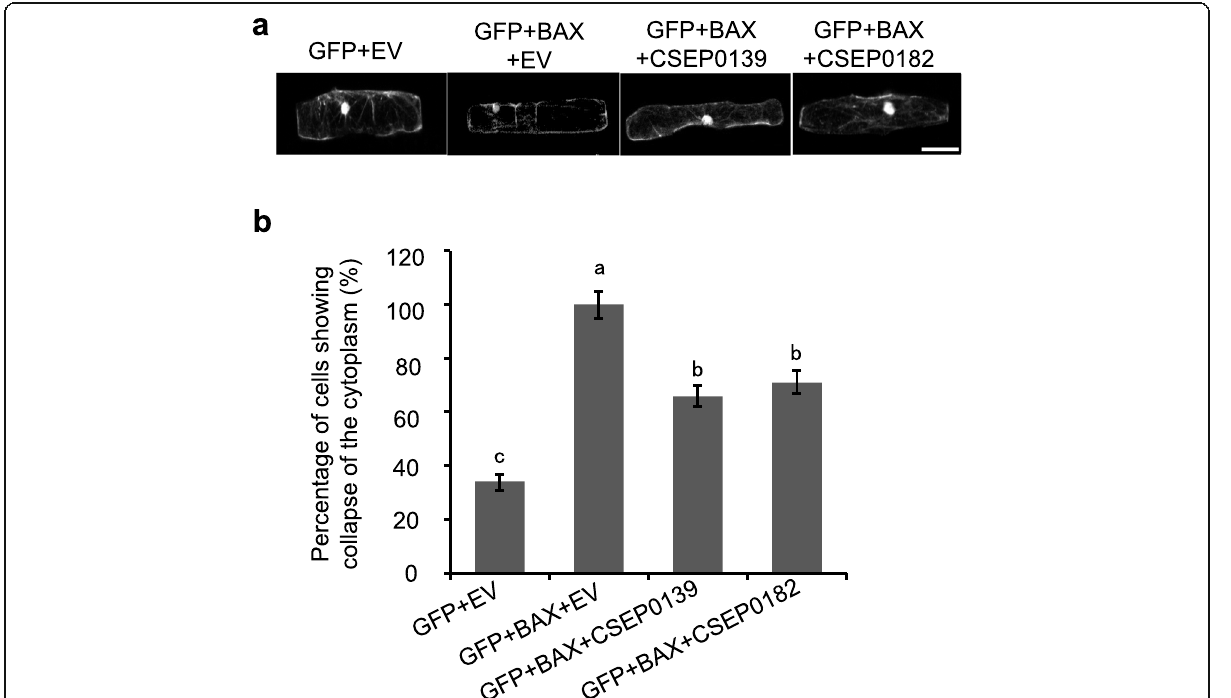
Fig. 4 CSEP0139 and CSEP0182 inhibit BAX-induced cell death in barley. a Suppression of BAX-triggered cell death by CSEP0139 and CSEP0182 in barley. Transient gene overexpression assay was conducted in barley epidermal cells by particle bombardment with combinations of plasmid expressing GFP and empty vector (EV), GFP and BAX and EV, GFP and BAX and CSEP0139, and GFP and BAX and CSEP0182, respectively. Representative pictures indicate that GFP fluorescence shows normal cytoplasmic strands in cells expressing GFP + EV, or GFP + BAX + CSEP0139 or GFP + BAX + CSEP0182, but shows collapsed cytoplasm strands in cell expressing GFP + BAX + EV. Photographs were taken using Nikon A1 confocal laser scanning microscope at 10 h after bombardment. Scale bar = 50 μ m. b Quantification of BAX-induced cell death suppressed by CSEP0139 or CSEP0182. The percentage of cells showing collapse of the cytoplasm was shown in various plasmid combinations. The combinations expressing GFP + EV and GFP + BAX + EV were set as controls. The coexpression of GFP and BAX and EV typically induced cell death, thus the percentage of transformed cells showing collapse of the cytoplasm in GFP + BAX + EV was set to 100%. Data shown are means of three replicates ±SE. Means with different letters are significantly different ( P < 0.05). Duncan ’ s multiple range test was used to compare all the means. At least 100 cells were counted per